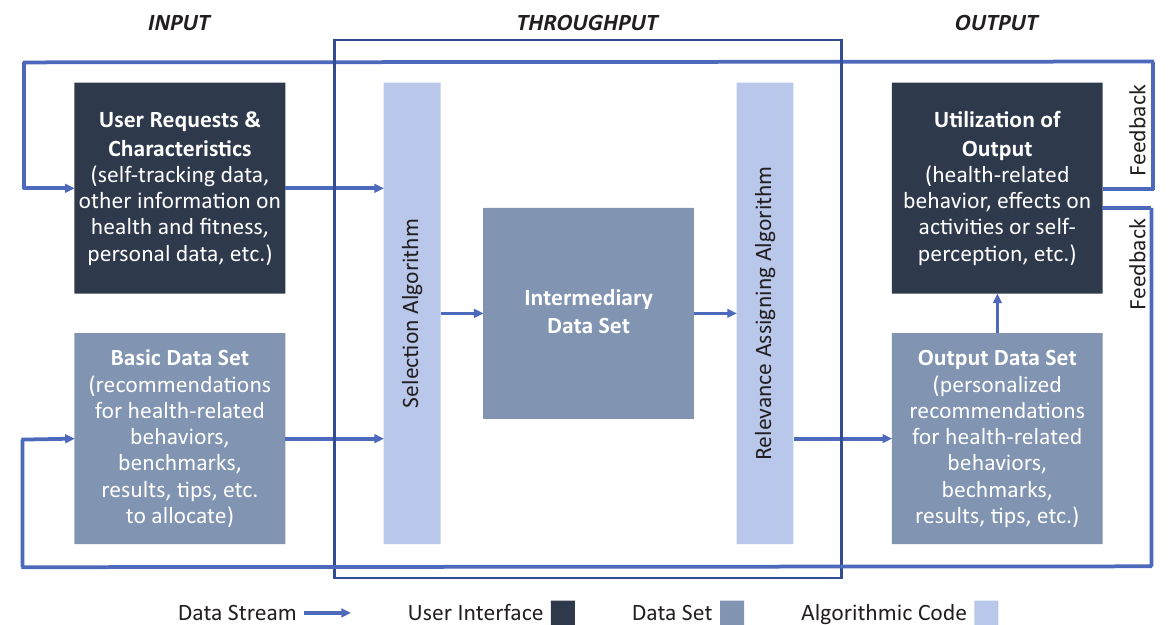
Figure 1. Input–throughput–output model of algorithmic selection applied to self‐tracking applications for health and fit‐ ness. Source: Adapted from Latzer et al.